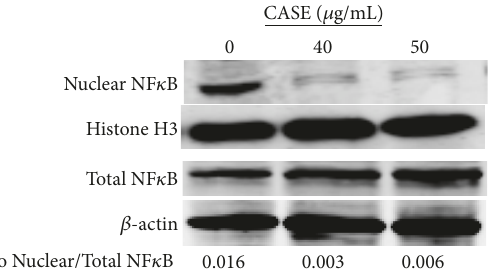
Figure 4: Effect of CASE on the expression of NF 𝜅 Bin LNCaP cells. Westernblotanalysiswasperformedafter12htreatmentwithCASE. Expression of total NF 𝜅 B was normalized to expression of 𝛽 -actin. Nuclear levels of NF 𝜅 B were normalized to histone H3. Results are representative of three independent